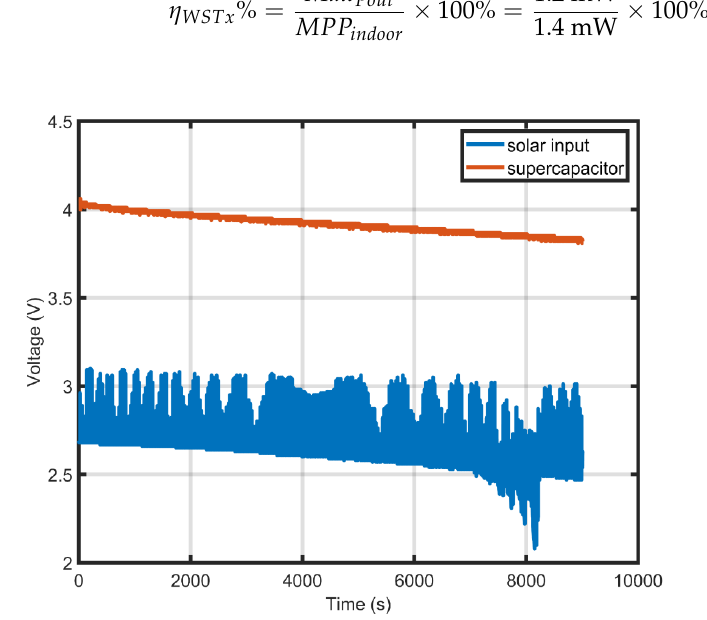
Figure 24. Energy harvesting profile, where ( a ) is the open-circuit energy harvesting and ( b ) is the closed-circuit energy harvesting. The significance of this study lies in the use of LoRa as a Communication Infrastruc- ture (CI) between the nodes, which significantly reduces the amount of power consumed